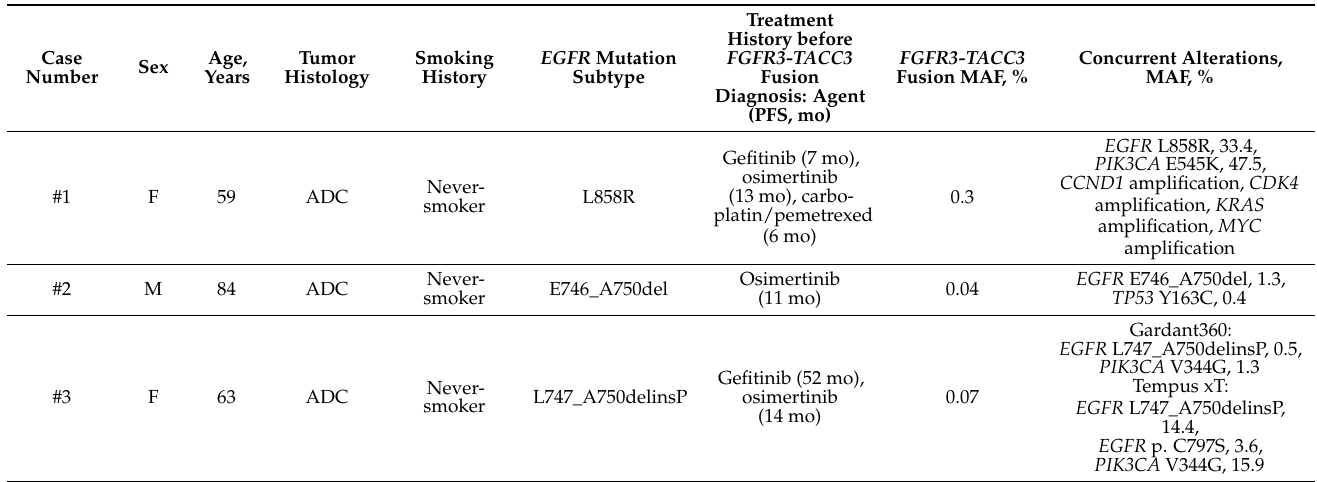
Table 3. Demographic and clinico-pathological characteristics of patients with EGFR mutant aNSCLC progressing on EGFR TKIs and developing an FGFR3-TACC3 fusion. All FGFR3-TACC3 fusions were detected by Guardant